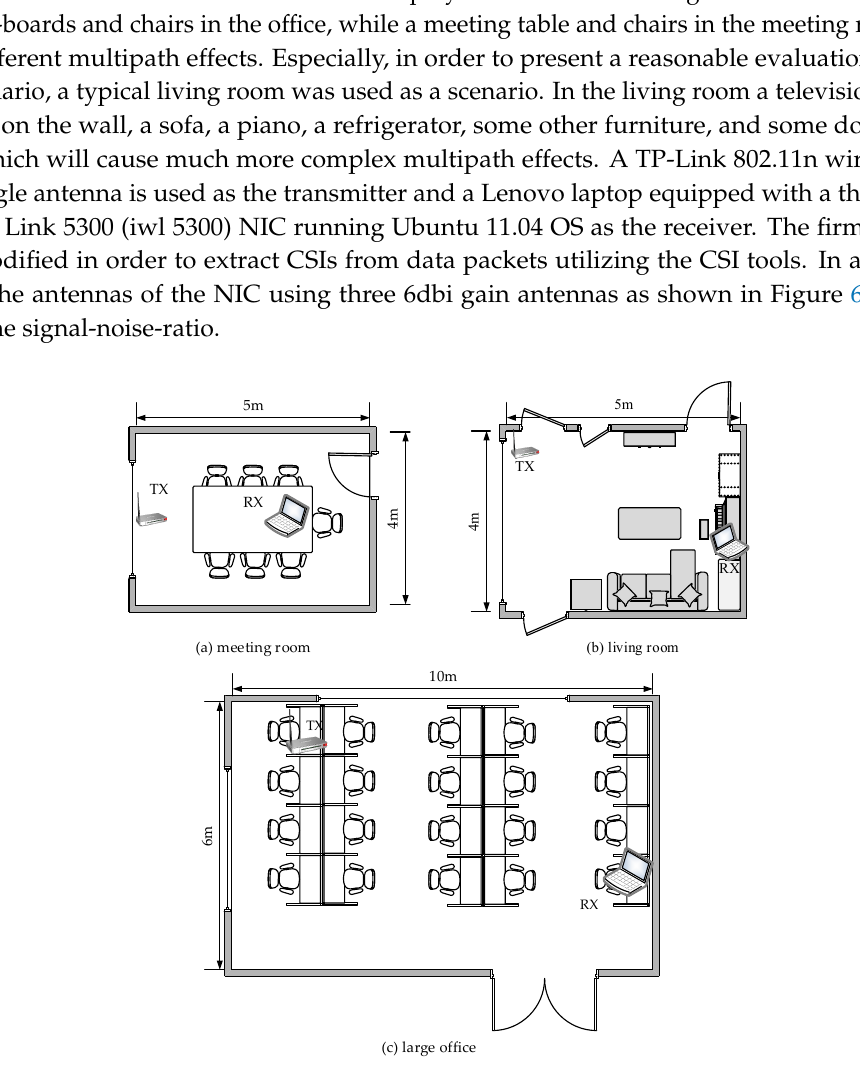
Figure 5. Experimental scenario.